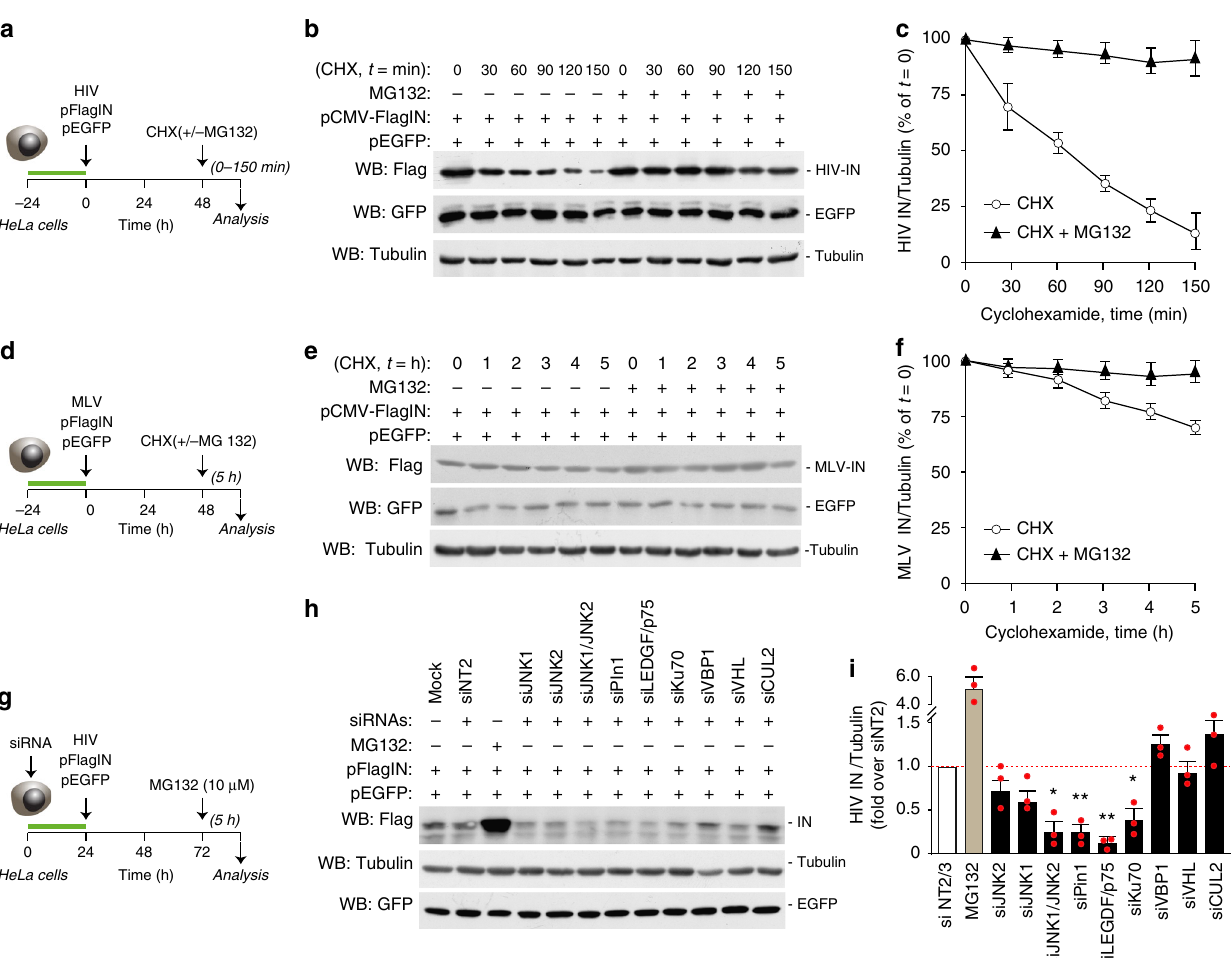
Fig. 1 Degradation of retroviral integrases by the host ubiquitin-proteasome system. a Schematic representation of the HIV-1 IN stability assay. HeLa cells were cotransfected with plasmids expressing Flag-tagged IN or EGFP; 48 h later, cells were treated with cycloheximide (CHX) in the presence and absence of the proteasome inhibitor MG132. b Measurement of HIV-1 IN stability. Flag-IN-expressing HeLa cells were treated with CHX (30 μ g/ml) with or without MG132, followed by protein detection at different time points using an anti-Flag antibody. Tubulin levels served as a loading control and EGFP levels as a transfection and speci fi city control. c Quanti fi cation of HIV-1 IN protein levels in the presence and absence of MG132 in CHX-treated cells at the indicated time points. Data are mean ± SEM; n = 3 independent experiments. d Schematic representation of the MLV IN stability assay. e Measurement of MLV- IN stability. Experiments were performed as in panel c . f Quanti fi cation of MLV-IN protein levels. Data are mean ± SEM; n = 3 independent experiments. g Knock-down of cellular factors to assess HIV-1 IN levels. HeLa cells were transfected with a plasmid expressing pFlag-IN and either transfected 24 h in advance with siRNAs against selected cellular factors or treated, 48 h later, with MG132. h Representative experiment showing the levels of HIV-1 IN after knock-down of selected cellular factors by RNAi, as indicated. Cell treatment with MG132 served as a positive control. IN levels were analyzed in whole cell lysates by immunoblotting with anti-Flag antibody. Immunoblotting for Tubulin served as a loading control. The bottom panel shows a western blotting for EGFP in a representative experiment to show lack of effect of any of the tested siRNAs on EGFP levels. i Quanti fi cation of HIV-1 IN levels in whole cell extracts of cells in which the indicated factors were knocked down by siRNA transfection. Data are normalized for Tubulin levels and expressed as fold over cell treatment with non-targeting NT2 siRNA control. Data are mean ± SEM; n = 3 independent experiments; * P < 0.05; ** P < 0.01; one-way